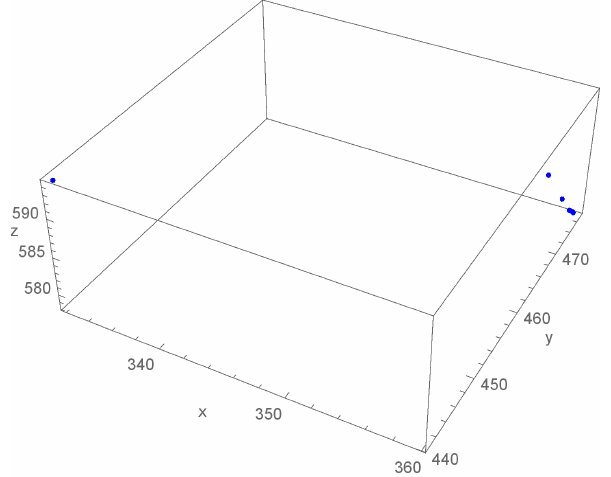
Figure 6. Attractor of x n , y n and z n as dot graph for α = 167, β = 0.01, γ = 0.03, δ = 0.4, ζ = 155, η = 0.05, µ = 0.05, ε = 0.3, υ = 144, ρ = 0.03, σ = 0.08, ω = 0.2. with initial conditions x 0 = 10.0, y 0 = 20.0 and z 0 =